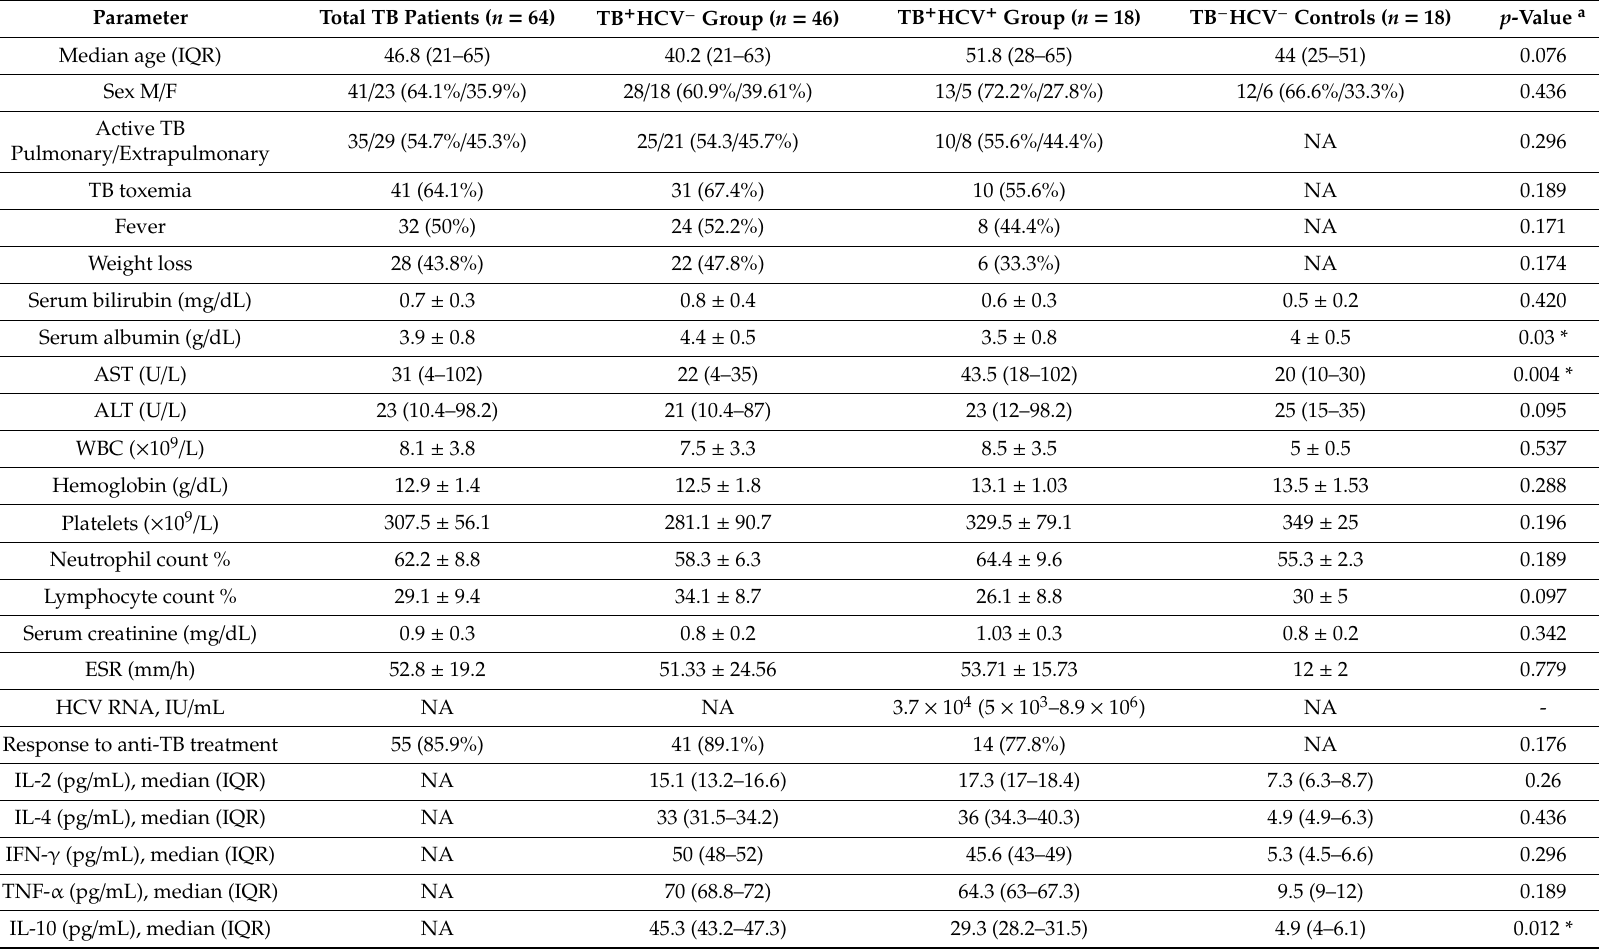
Table 1. Demographic, clinical, and laboratory characteristics of tuberculosis (TB) patients in this